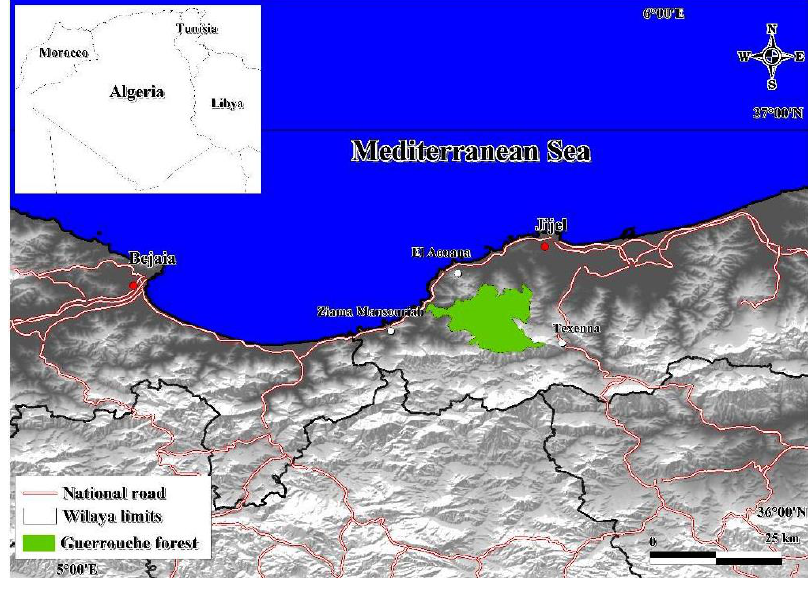
Fig. 1. Geographical location of the study area of the Guerrouche Forest